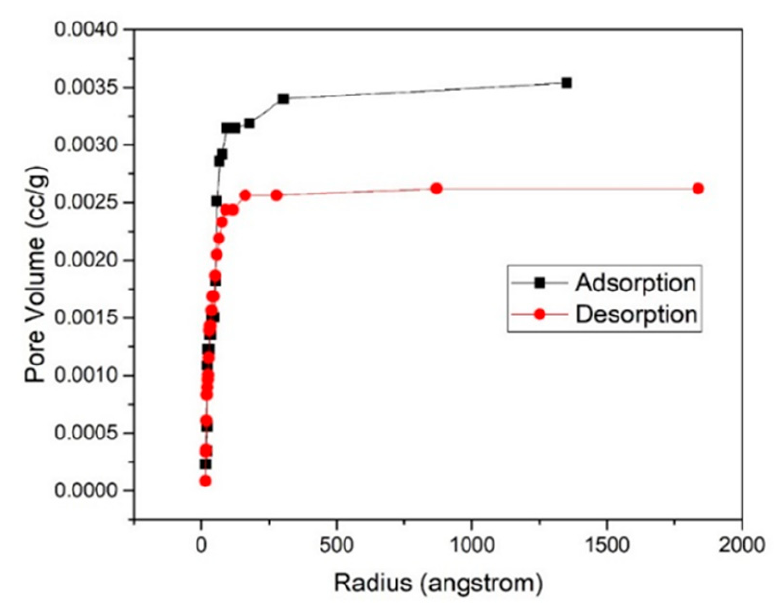
Figure 6. Adsorption-Desorption Curve 7% PVP.